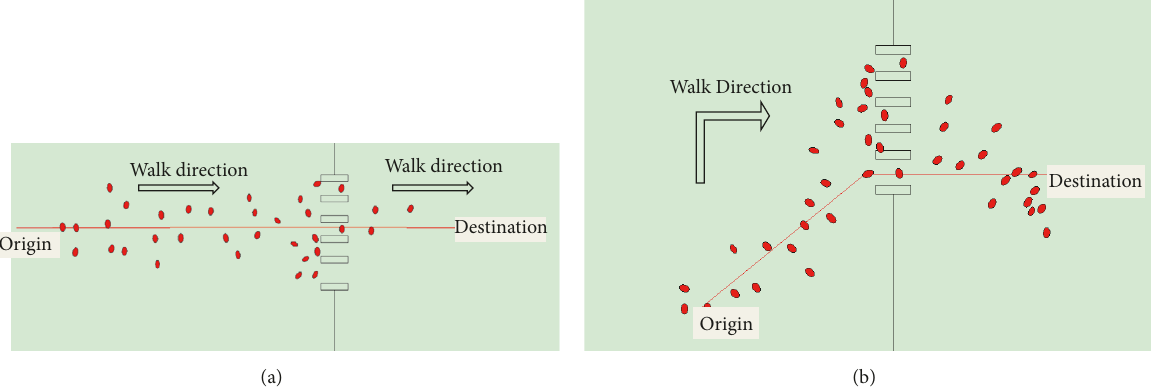
Figure 4: The two simulation scenarios: (a) symmetric layout and (b) asymmetric